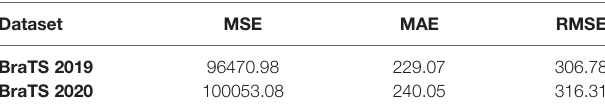
TABLE 4 | The survival prediction result of BraTS 2019 and BraTS 2020.